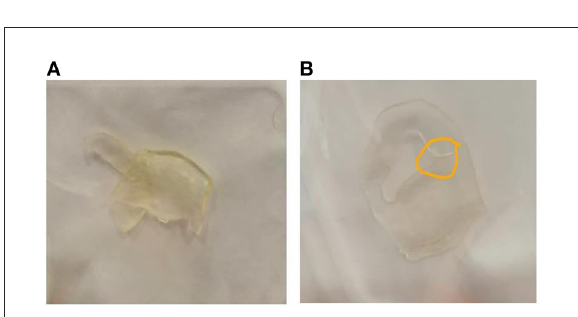
FIGURE4 Damaged samples during the sterilization process. (A) prototype in MED625FLX 2.2mm damaged during sterilization; (B) prototype in MED625FLX 1mm damaged during